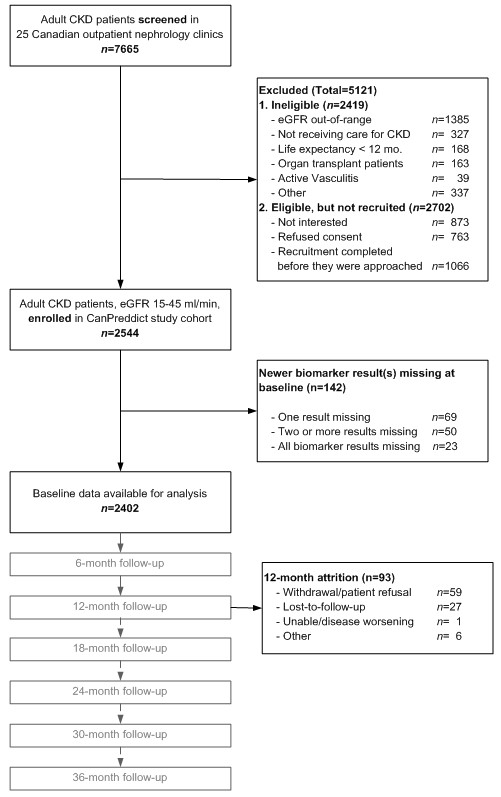
Cohort flow diagram.